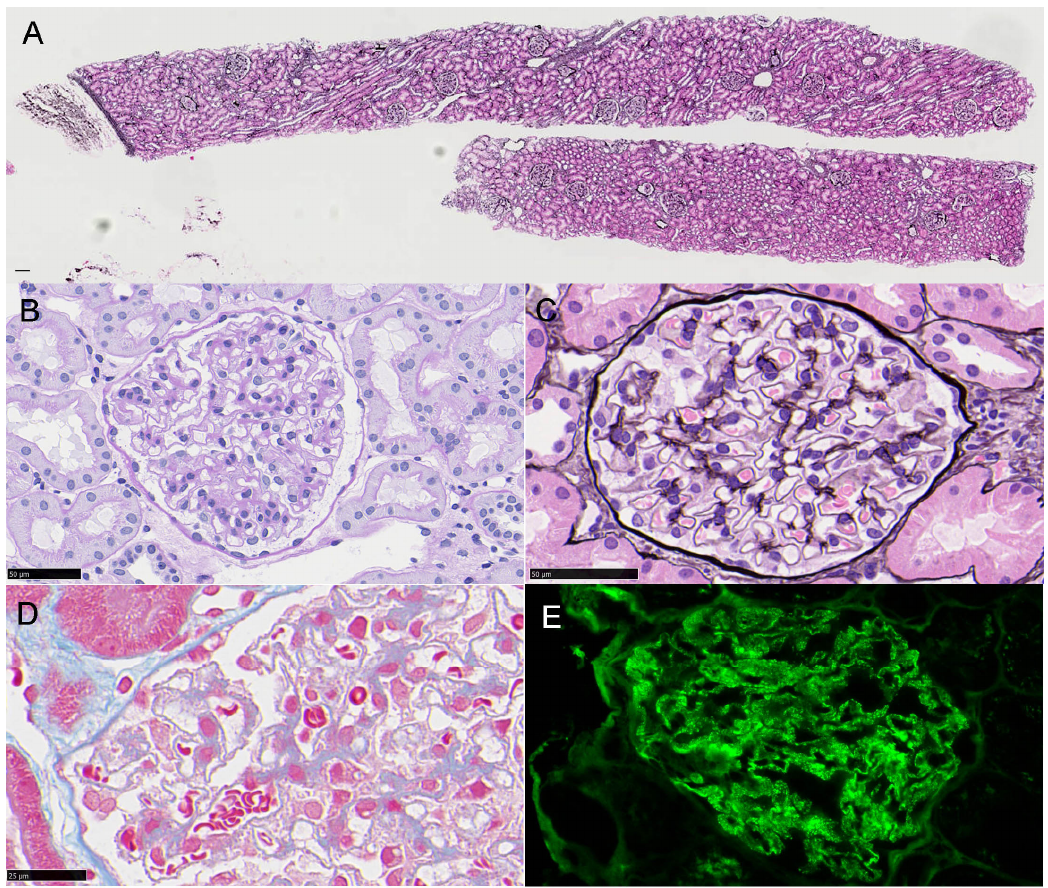
Figure 1. Renal biopsy. PAM staining ( A , C ), PAS staining ( B ), Azan staining ( D ), and immunofluo- rescence of IgG. The bars indicate 50 μ m ( B , C , E ) and 25 μ m ( D ).